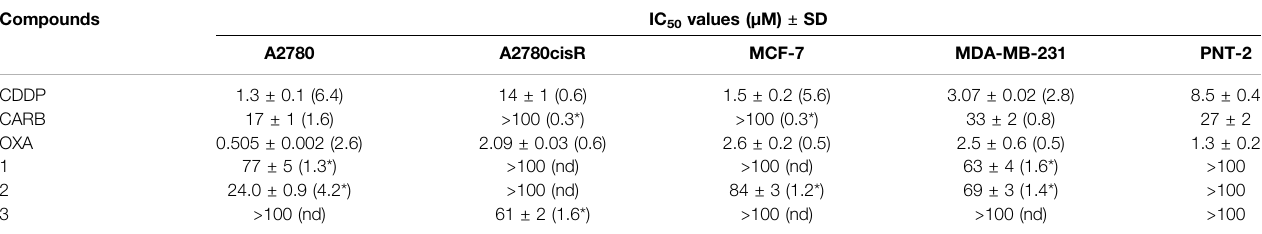
TABLE 2 | Cytotoxicity values (IC 50 / μ M ± SD) for cisplatin (CDDP), oxaliplatin (OXA), carboplatin (CARB) and compounds 1 – 3 after a 96 h incubation period with human ovariancarcinomas(A2780,A2780cisR),humanbreastadenocarcinomas(MCF-7,MDA-MB-231)andnon-malignantprostatecells(PNT-2). a SelectiveIndex(SI)values when compared to PNT-2 are shown in